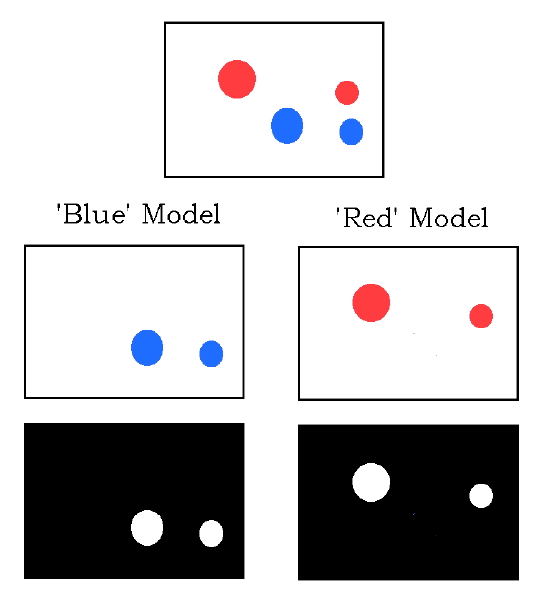
Figure 1 – Exemplar data for two models, ‘Red’ and ‘Blue’, showing predicted areas where the models expect the most frequently fixated regions to occur. Top panel shows both models together, middle panel shows the models separately, and the lower panel shows the binarised map that is used as the models input to